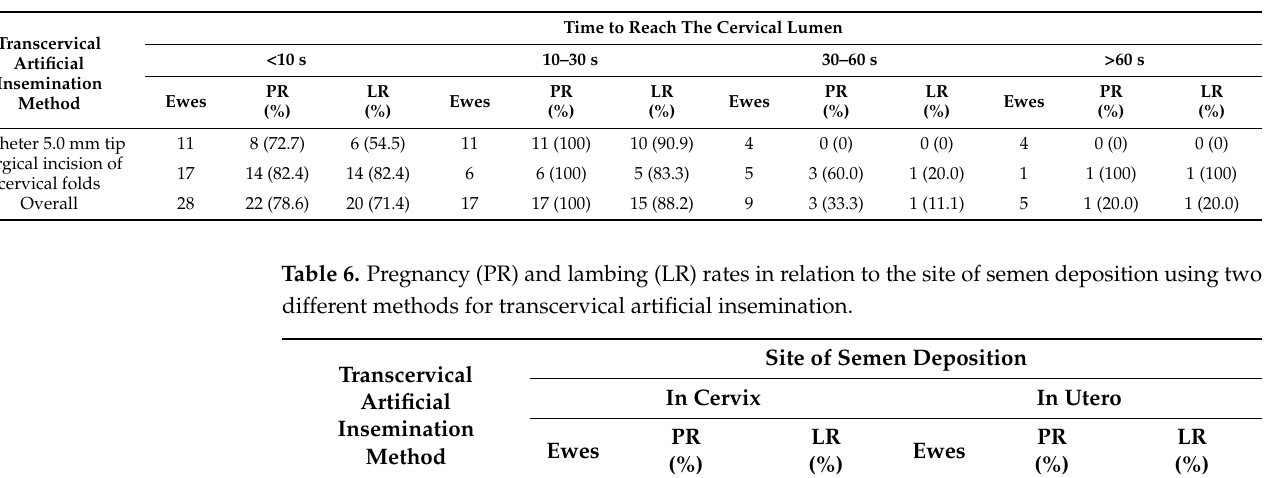
Table 5. Pregnancy (PR) and lambing (LR) rates in relation to the time taken to reach the cervical lumen using two different methods for transcervical artificial insemination.